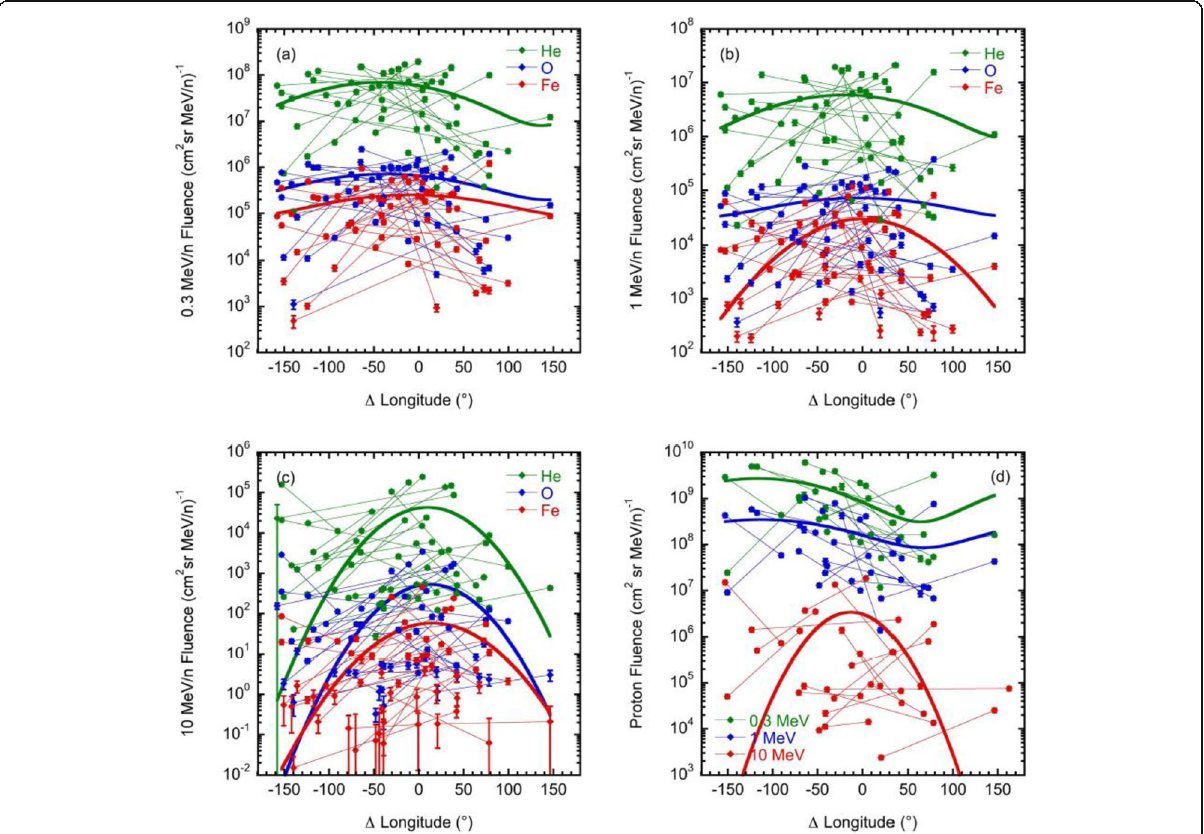
Fig. 23 Peak intensities of He, O, and Fe as a function of flare-spacecraft footpoint separations ( Δ Longitude) of two-spacecraft events (Cohen et al. 2017). Negative values of Δ Longitude correspond to footpoints west of the flare location, and positive values correspond to locations east of the flare. The different panels show different energies with ( a ) 0.3, ( b ) 1, and ( c ) 10 MeV/n. Panel ( d ) shows protons at all three energies. Individual events are connected by lines, the thick curves show periodic Gaussian